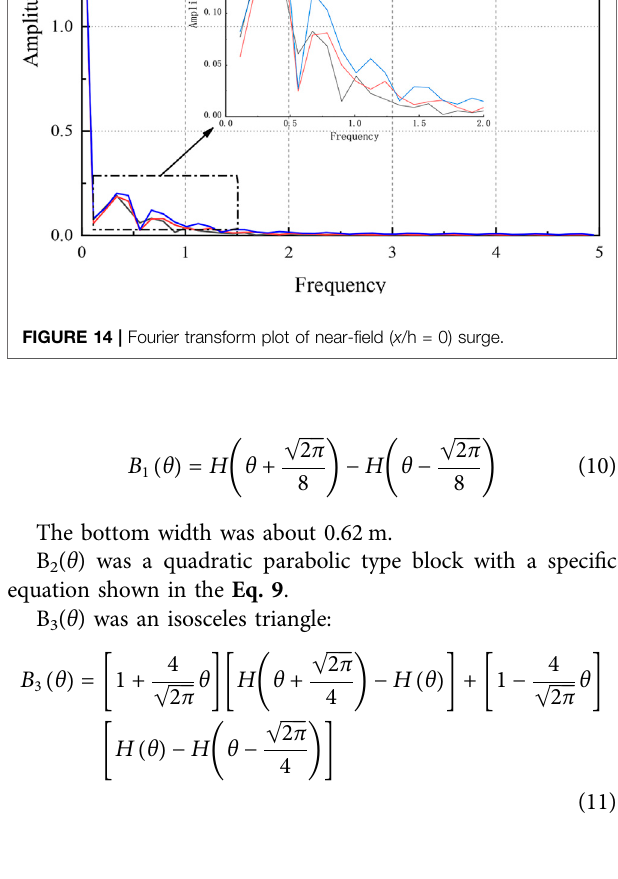
Frontiers in Physics |